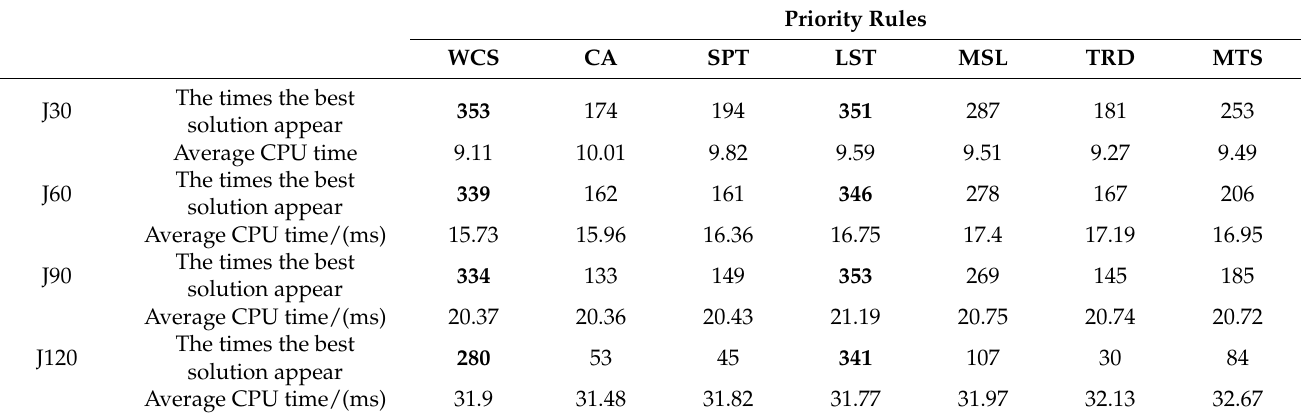
Table 3. Results of the parallel schedule scheme-based